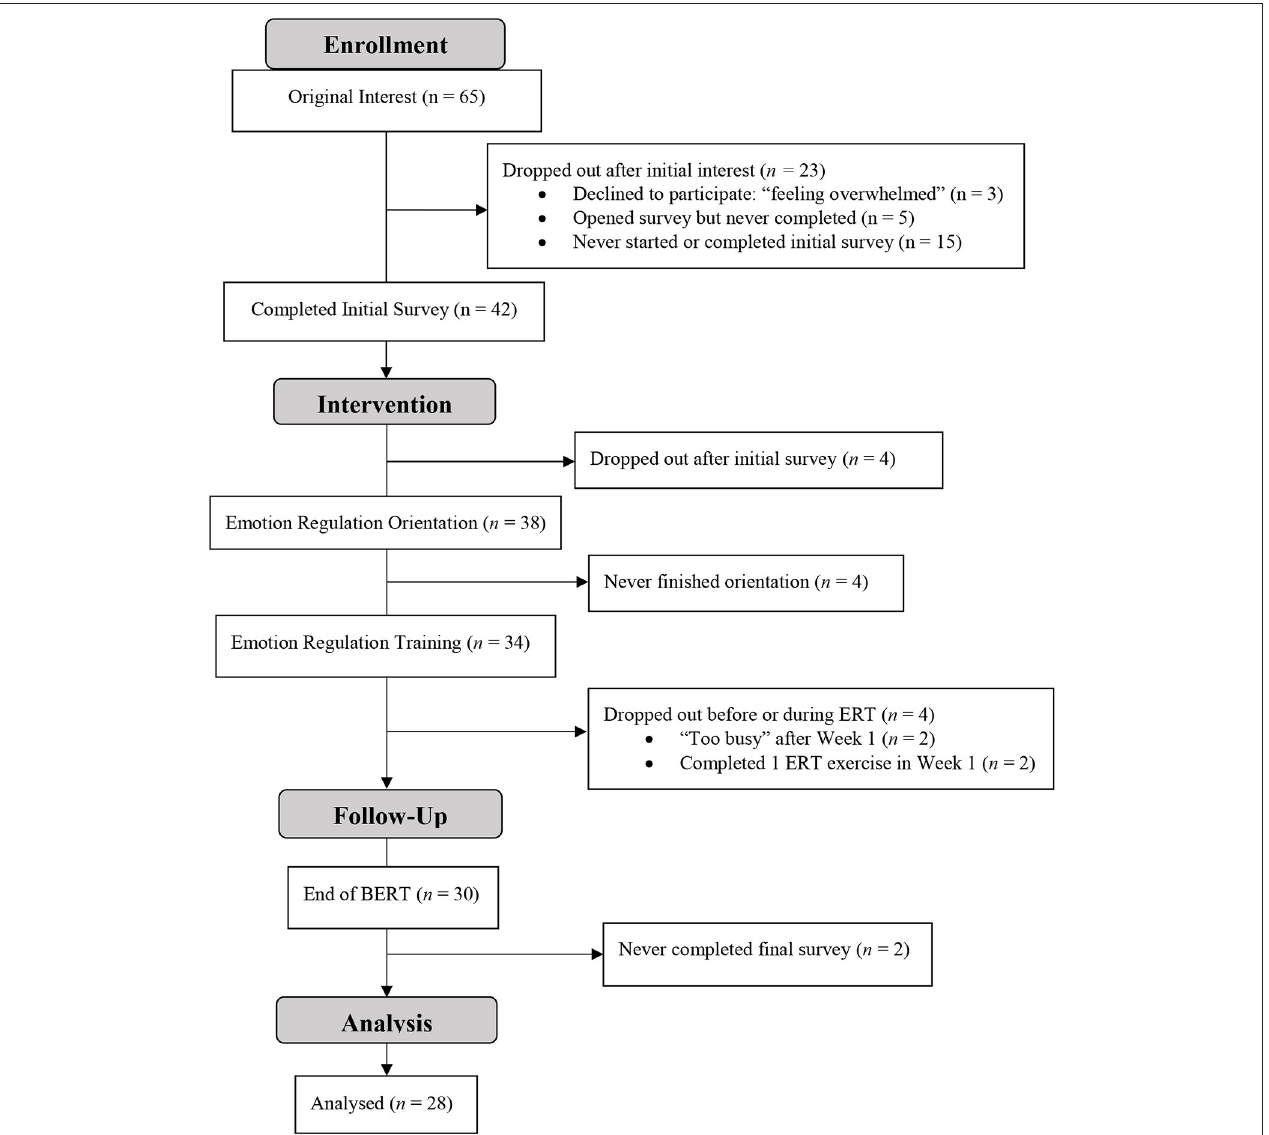
FIGURE 1 | Consort diagram to examine BERT completion rates and